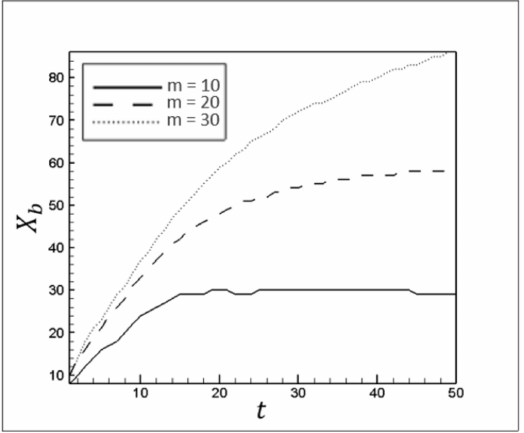
Figure 24. The location of the advancing front at the top of the channel over time for different m.